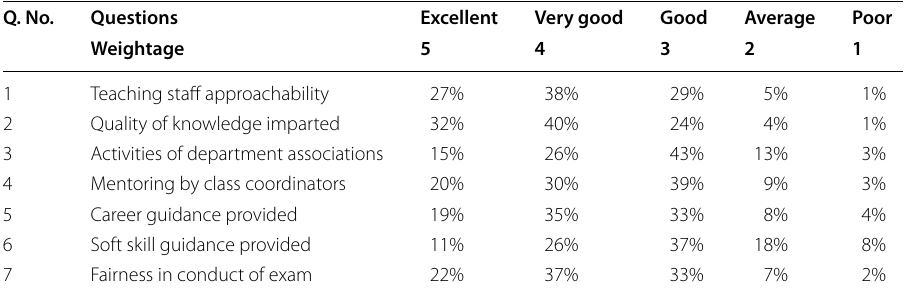
Table 3 Responses obtained to find quality and effectiveness of library services Q. No.